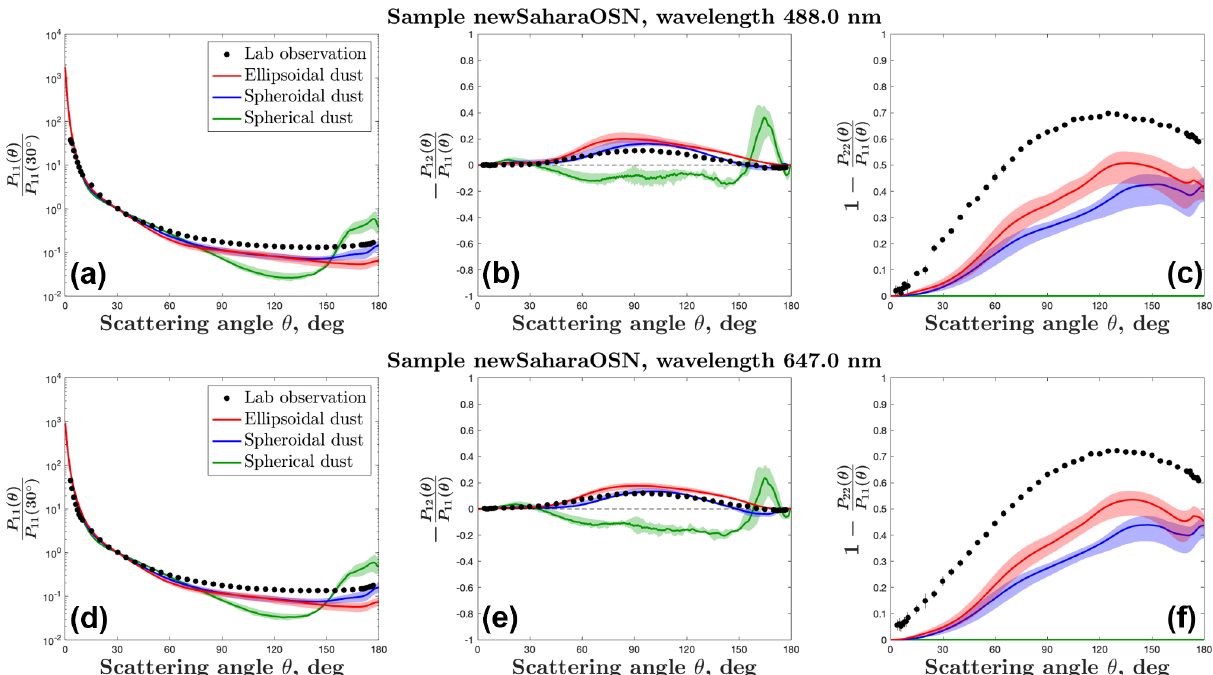
Figure 5. Same as Fig. 3, except for comparison of the laboratory-measured scattering matrix of AGLSD dust sample newSaharaOSN against the spherical, spheroidal, and ellipsoidal dust optics simulations at the wavelengths of 488.0 and 647.0nm.